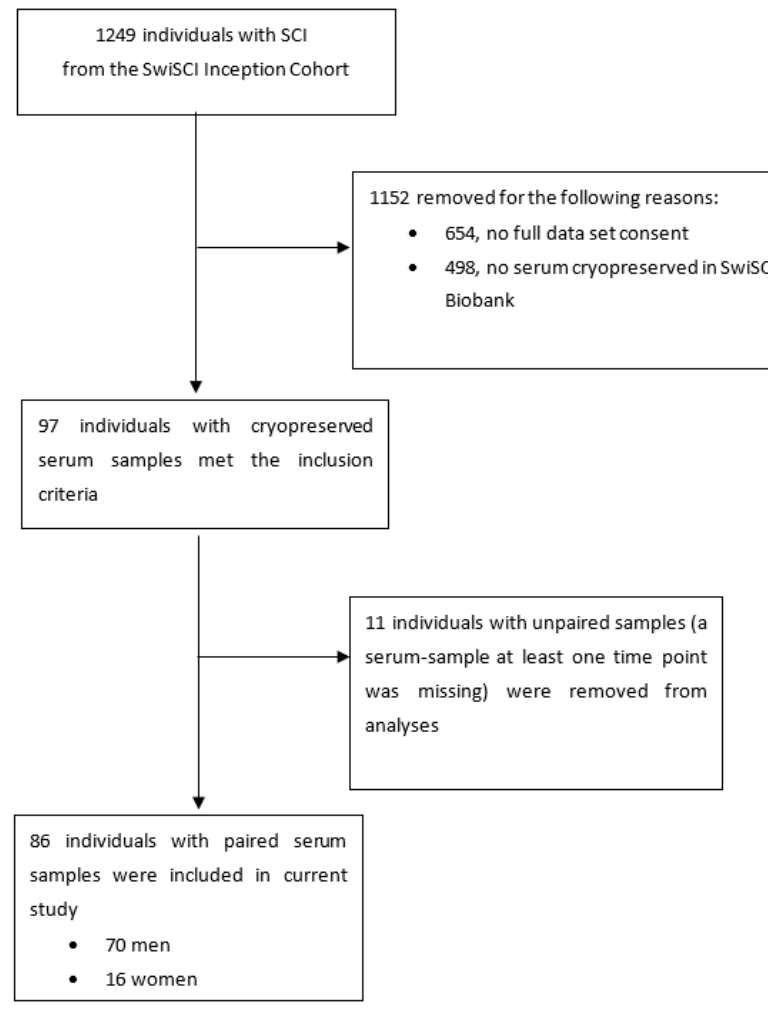
Figure 1. Flowchart of study participants. Table 1. Baseline Characteristics of the SCI individuals (beginning of rehabilitation).